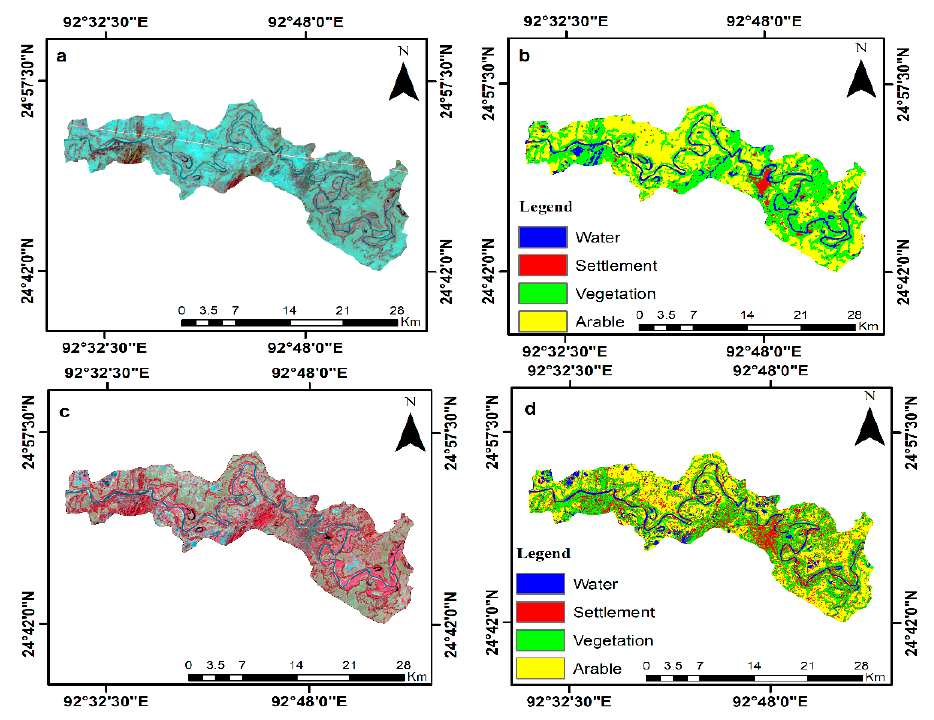
Figure 3. Landsat image of 1984 and 2017 ( a and c ). Land use land cover map of the Barak River of 1984 and 2017 ( b and d ).